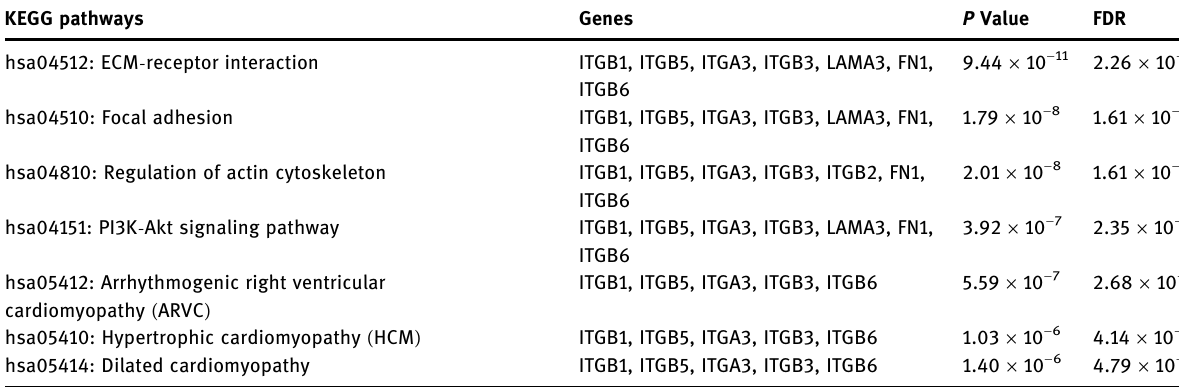
Table 4: Functional enrichment analysis for the pathways related to ITGA3 KEGG pathways